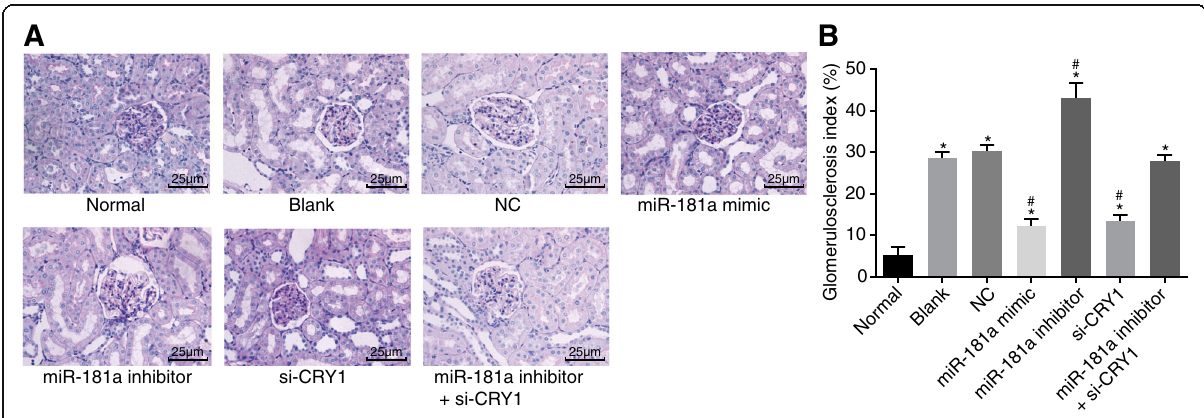
Fig. 5 PASM staining (× 400) shows that up-regulated miR-181a or down-regulated CRY1 reduces the GSI. Notes: Panel a , results of PASM staining under a microscope; Panel b , histogram of PASM results; * , p < 0.05 vs. the normal group; # , p < 0.05 vs. the blank and NC groups; the data are presented as the mean ± standard deviation, analyzed by one-way ANOVA; the experiment was independently repeated three times; NC, negative control; miR-181a, microRNA-181a; CRY1, cryptochrome 1; GSI, glomerulosclerosis index; PASM, periodic